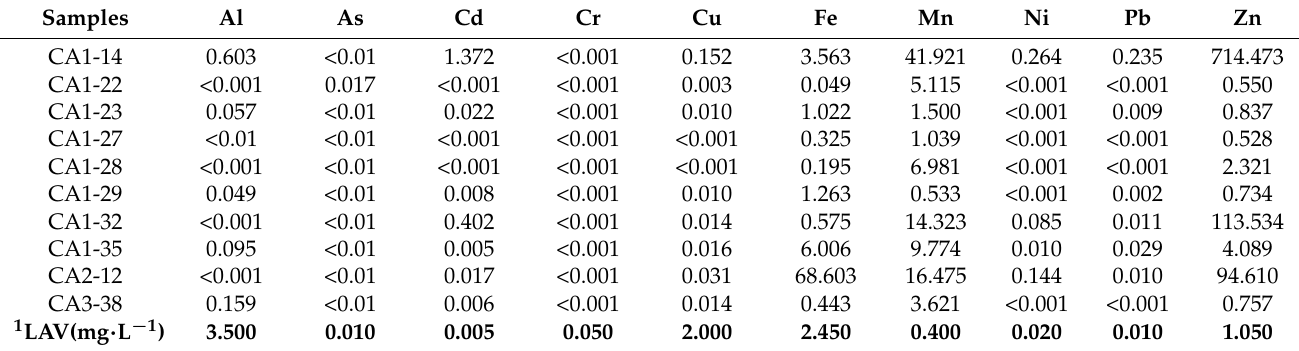
Table 2. Average values (mg · L − 1 ) of the elements analyzed in the interstitial waters for the rainy season.